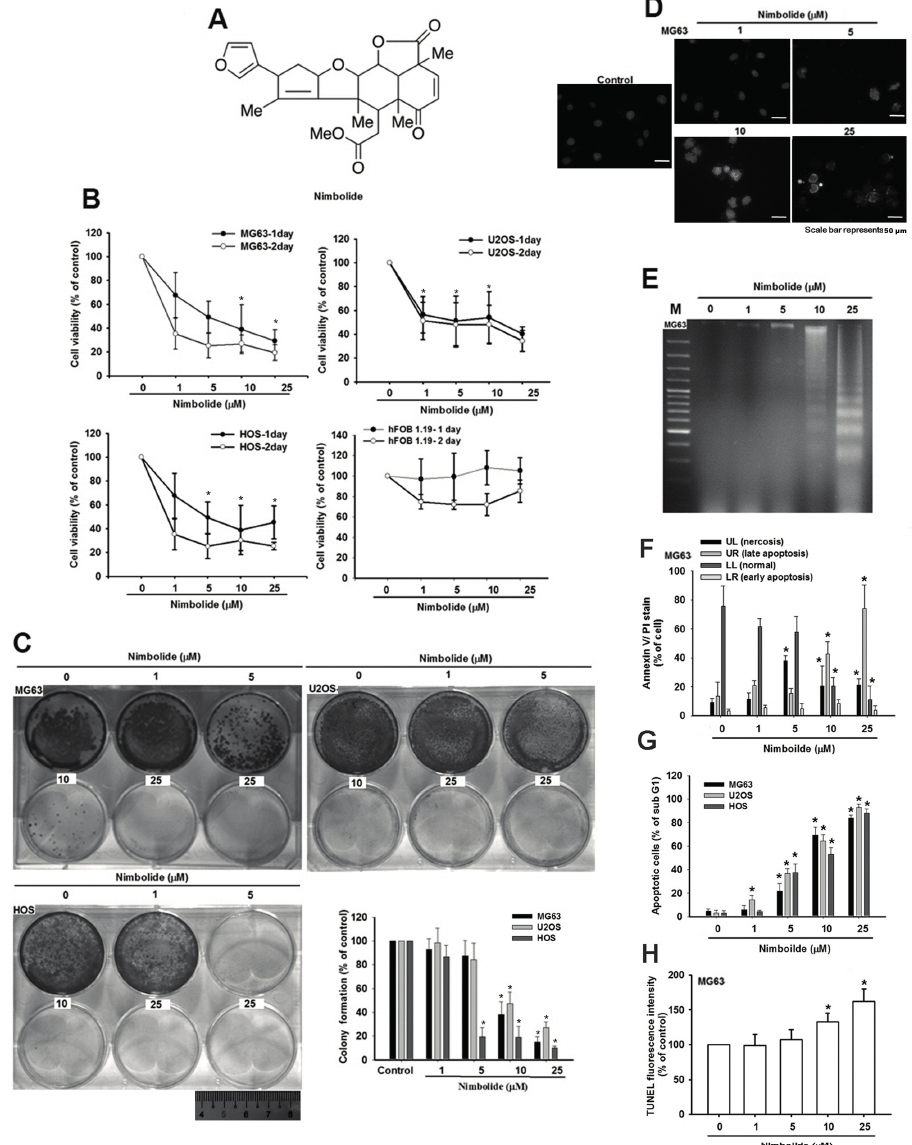
Figure 1. Nimbolide induces apoptosis in osteosarcoma cells. ( A ) The structure of Nimbolide. ( B , C ) Osteosarcoma cells (MG63, U2OS, and HOS) and osteoblast cells (hFOB 1.19) were incubated with control solution or various concentrations of Nimbolide for 1 or 2 days; ( B ) Cell viability was examined by using an MTT assay; ( C ) For the colony-formation assay, the cells were stained with crystal violet and photographed. The quantitative data are shown in the lower right panel; ( D ) MG63 osteosarcoma cells were incubated with control solution or various concentrations of Nimbolide for 24 h and nuclear morphology was recorded by using a DAPI stain and photography. Scale bar: 50 μ m; ( E ) MG63 osteosarcoma cell lysates were collected for DNA purification, and the DNA was analyzed by gel electrophoresis; ( F – G ) Osteosarcoma cells were incubated with control solution or various concentrations of Nimbolide for 24 h, and the percentages of apoptotic cells were analyzed by flow cytometric analysis of ( F ) annexin V and PI double-labeling, ( G ) PI staining, and ( H ) TUNEL staining. The data are expressed as the mean ± SEM. * p < 0.05 as compared with the control